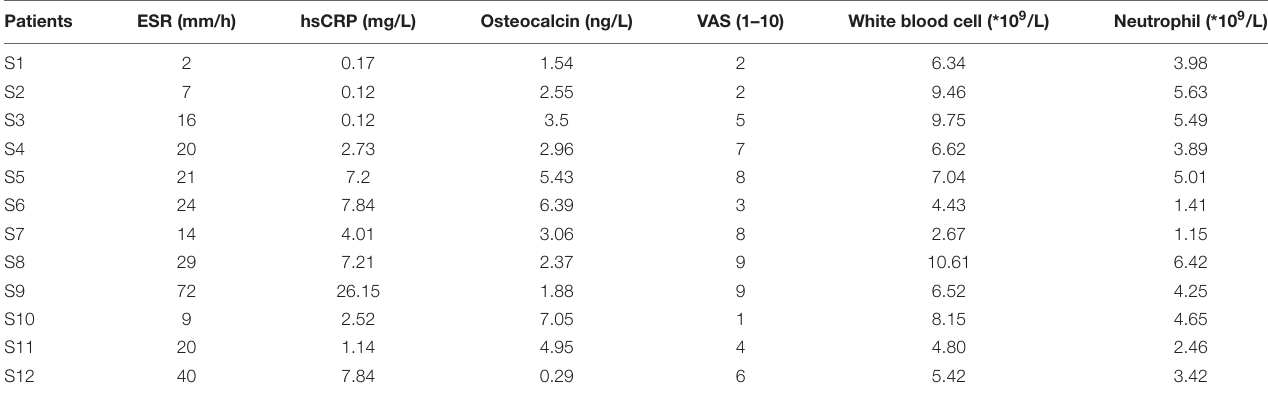
TABLE 1 | Clinical data of the twelve SAPHO patients. Patients